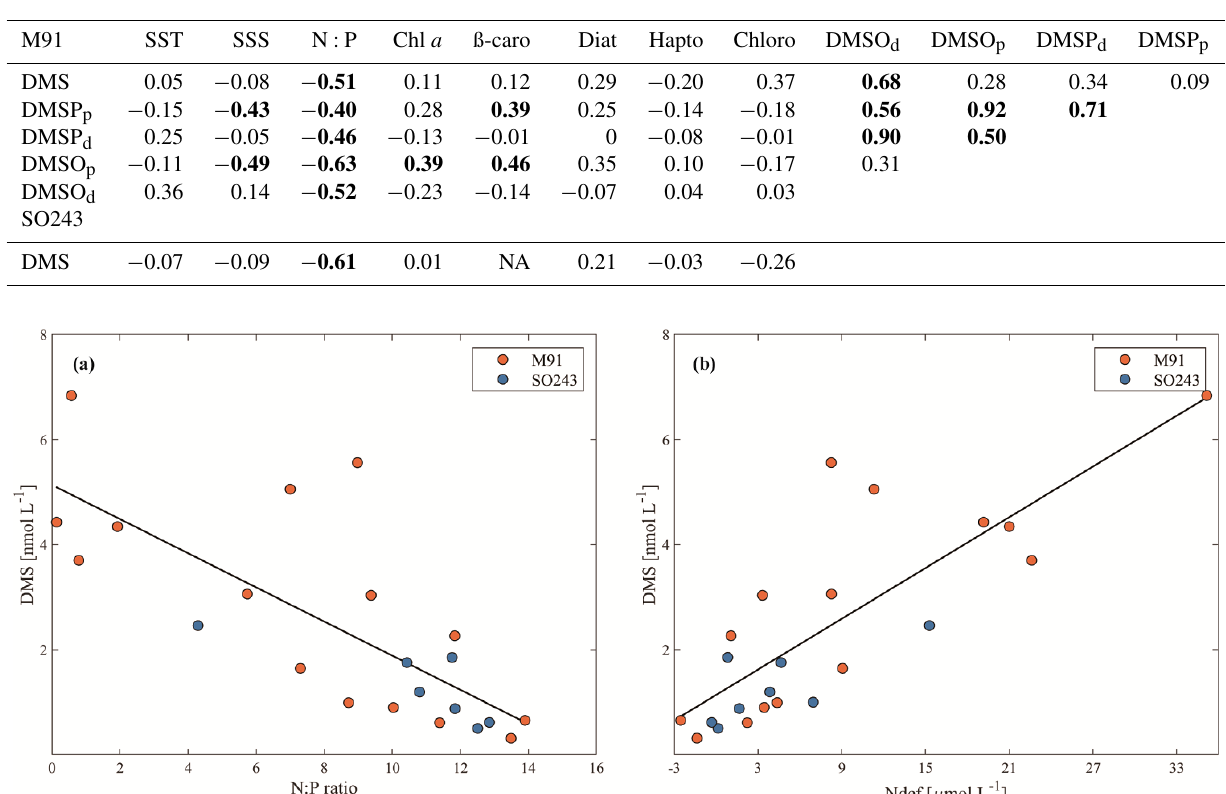
Table 1. Spearman’s rank coefficients of correlations of all sulfur compound surface data with selected abiotic and biological parameters. Bold numbers indicate correlations that are significant ( p< 0 . 05) with a sample size of 27 for M91, 36 (environmental and biological param- eters), and 13 (nutrients) for SO243 between 9–16 ◦ S. ß-caro represents ß-carotene, diat represents diatoms, hapto represents haptophytes, and chloro represents chlorophytes. NA represents not available.